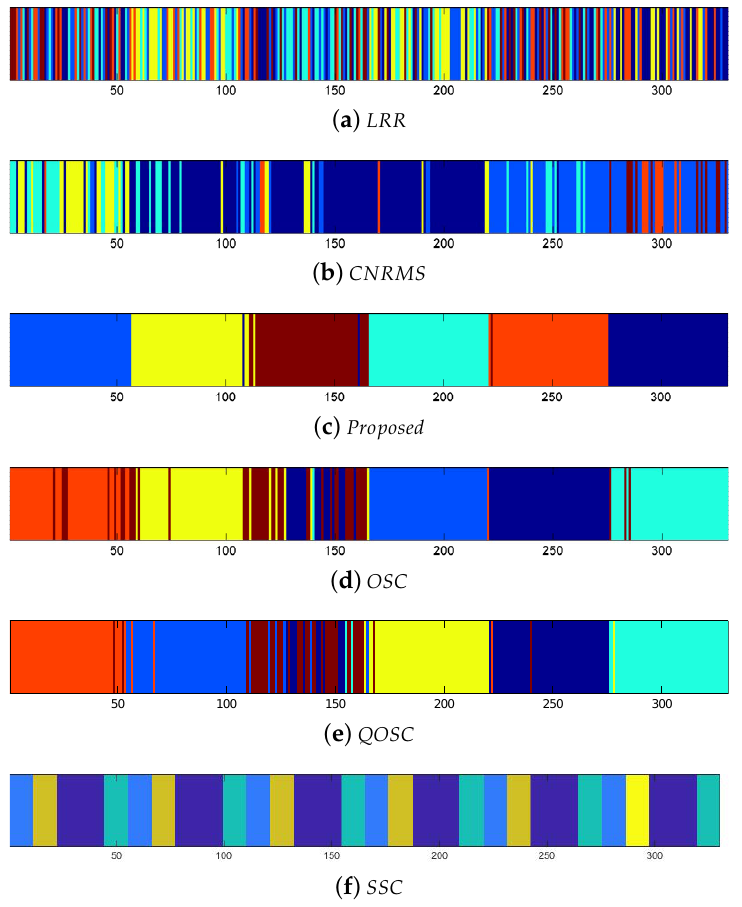
Figure 3. Clustering results of six expressions of five subjects on the BU-4DFE